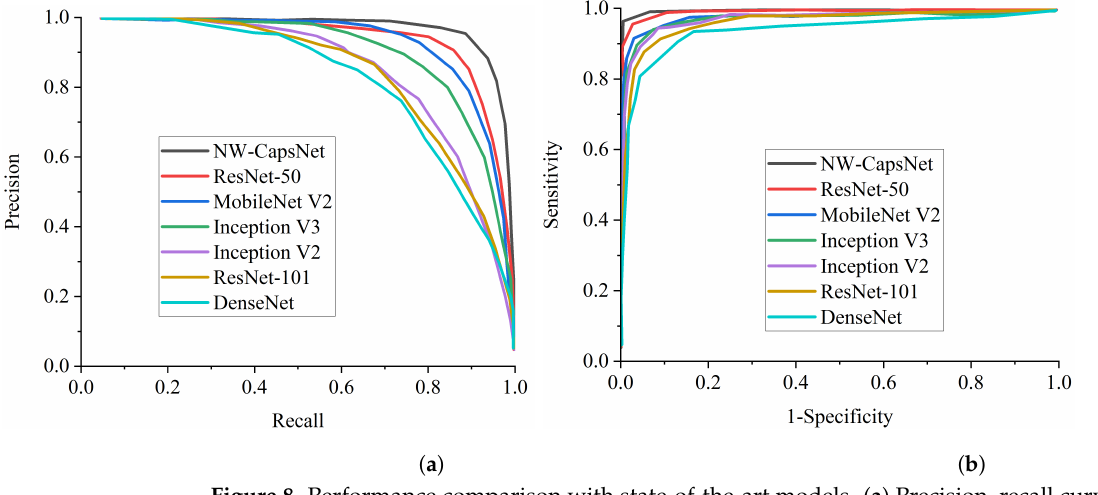
Figure 8. Performance comparison with state-of-the-art models. ( a ) Precision–recall curves of our proposed NW-CapsNet model in comparison to some selected pre-trained deep learning models. ( b ) ROC curve of our proposed NW-CapsNet model in comparison to some selected pre-trained deep learning